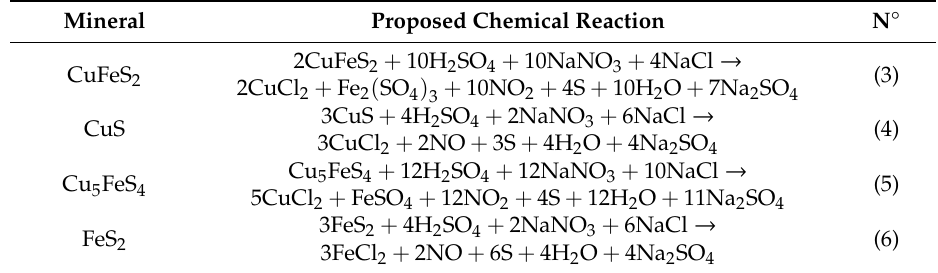
Table 7. Chemical reactions proposed for the pretreatment stage in acid-chloride-nitrate media.